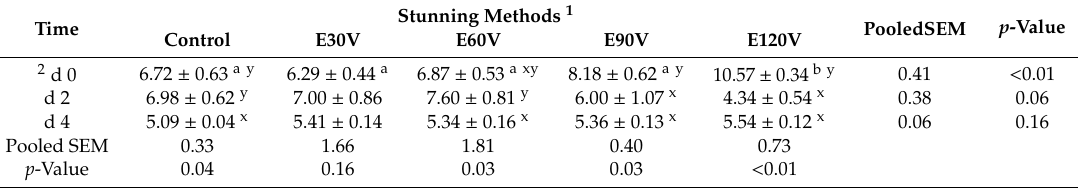
Stunning Methods 1